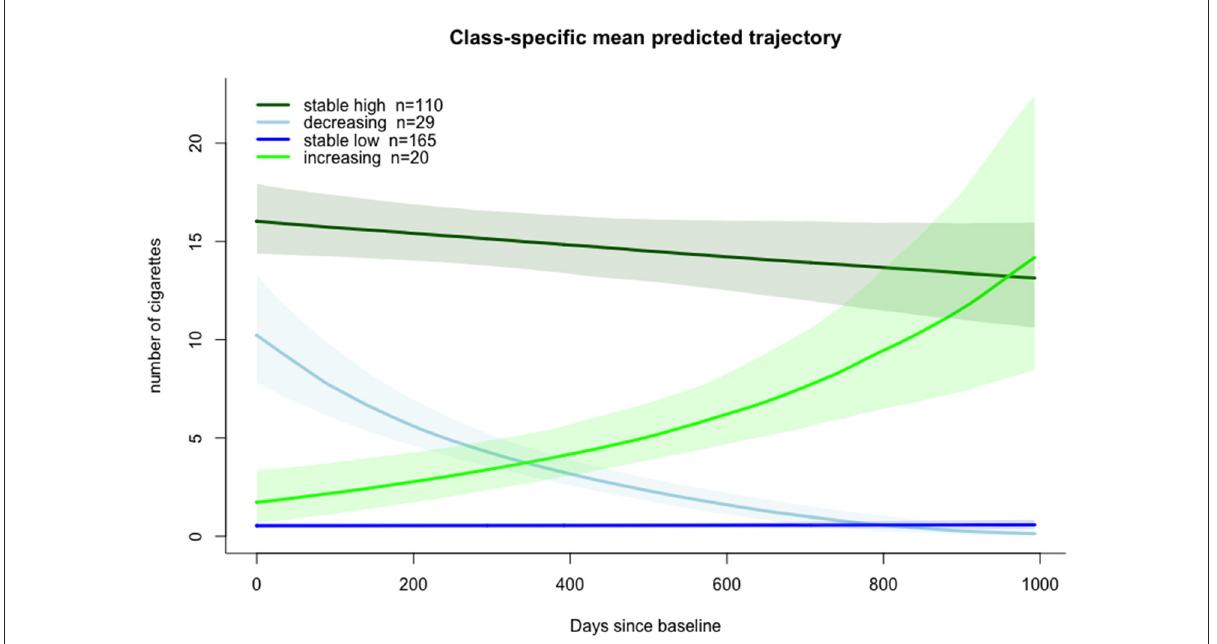
FIGURE1 Model estimated class-specific mean predicted trajectories of tobacco smoking with 95% confidence intervals.